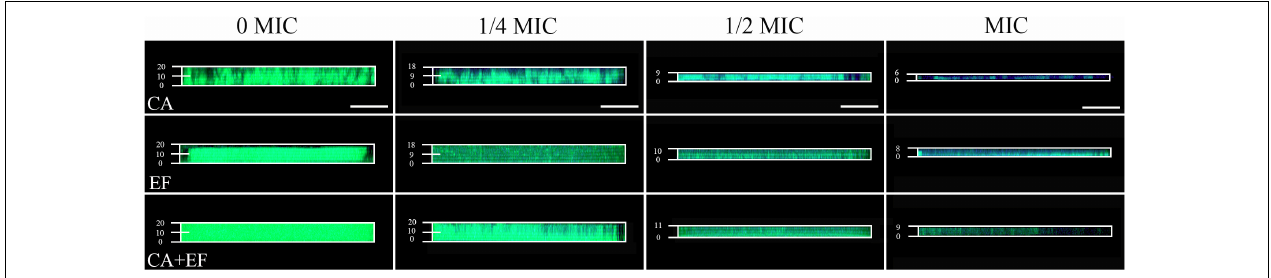
FIGURE 6 | Examination of the diffusion of antibiotics within C. albicans SC5314 (CA) and E. faecalis 20033 (EF) single and dual species (CA + EF) biofilms formed in the presence of luteolin using gatifloxacin as a model by confocal laser scanning microscope (CLSM). Biofilms were examined with SYTO 9 (green) and the intrinsic fluorescence of gatifloxacin (blue). Scale bars represent 20 µ m.